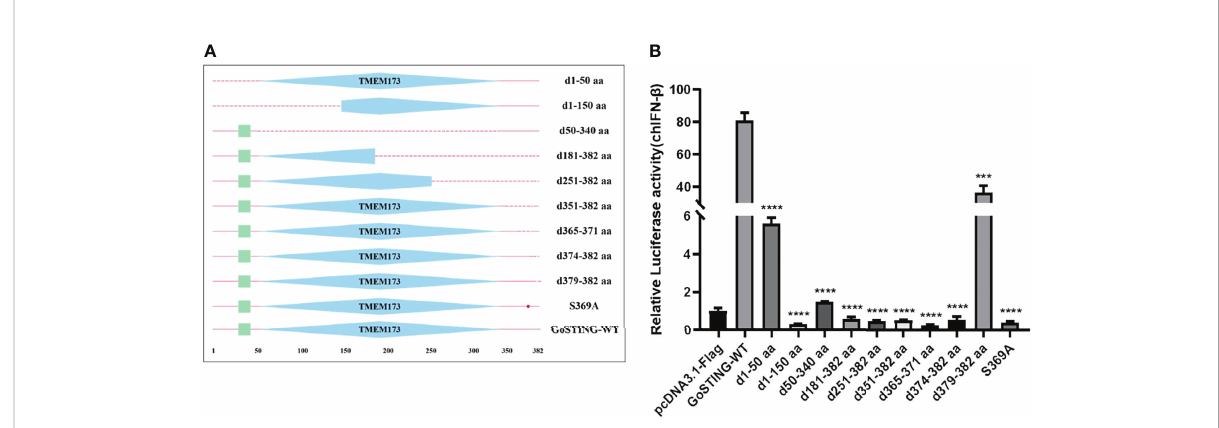
FIGURE 5 The Essential Domains of GoSTING in IFN Activation. (A) Schematic structure of GoSTING mutants. (B) The effects of GoSTING truncated mutants on IFN- b promoter activity. Cells were transfected with different expression plasmids of GoSTING and the reporter plasmids pGL-IFN- b -Luc and internal control Renilla luciferase (pRL-TK). Luciferase assays were performed 24h after transfection. All luciferase assays were repeated at least three times, and the difference between the experimental and control groups was ***p<0.001 or **** P